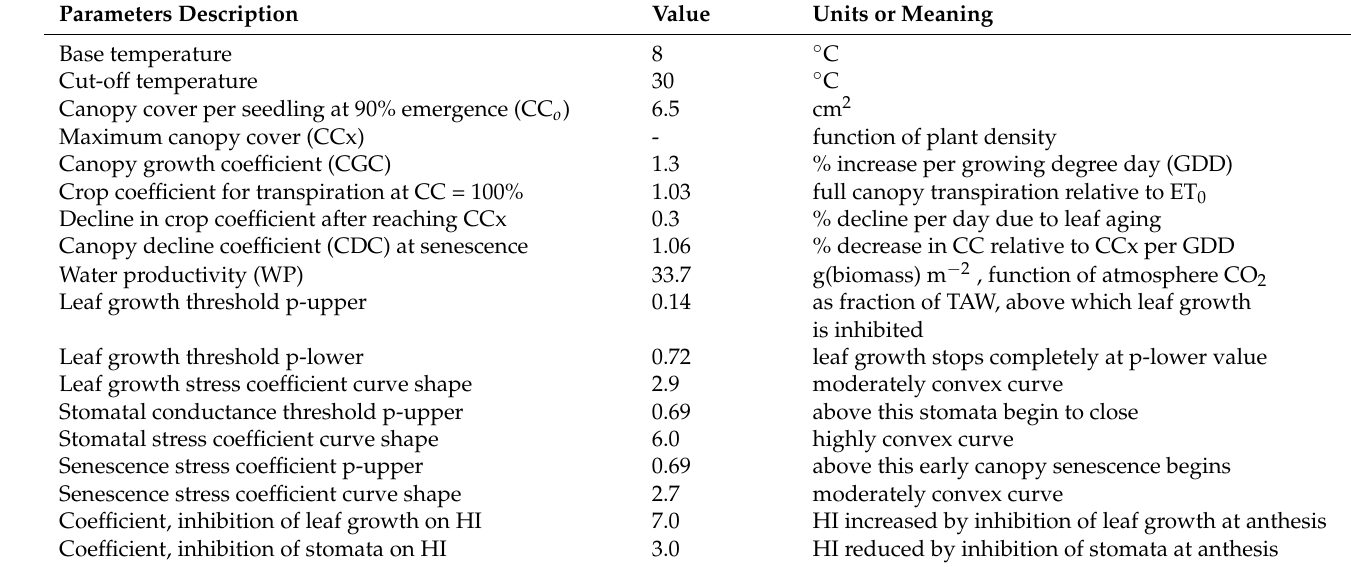
Table 2. Conservative maize parameters (from [32] used in the AquaCrop simulations).